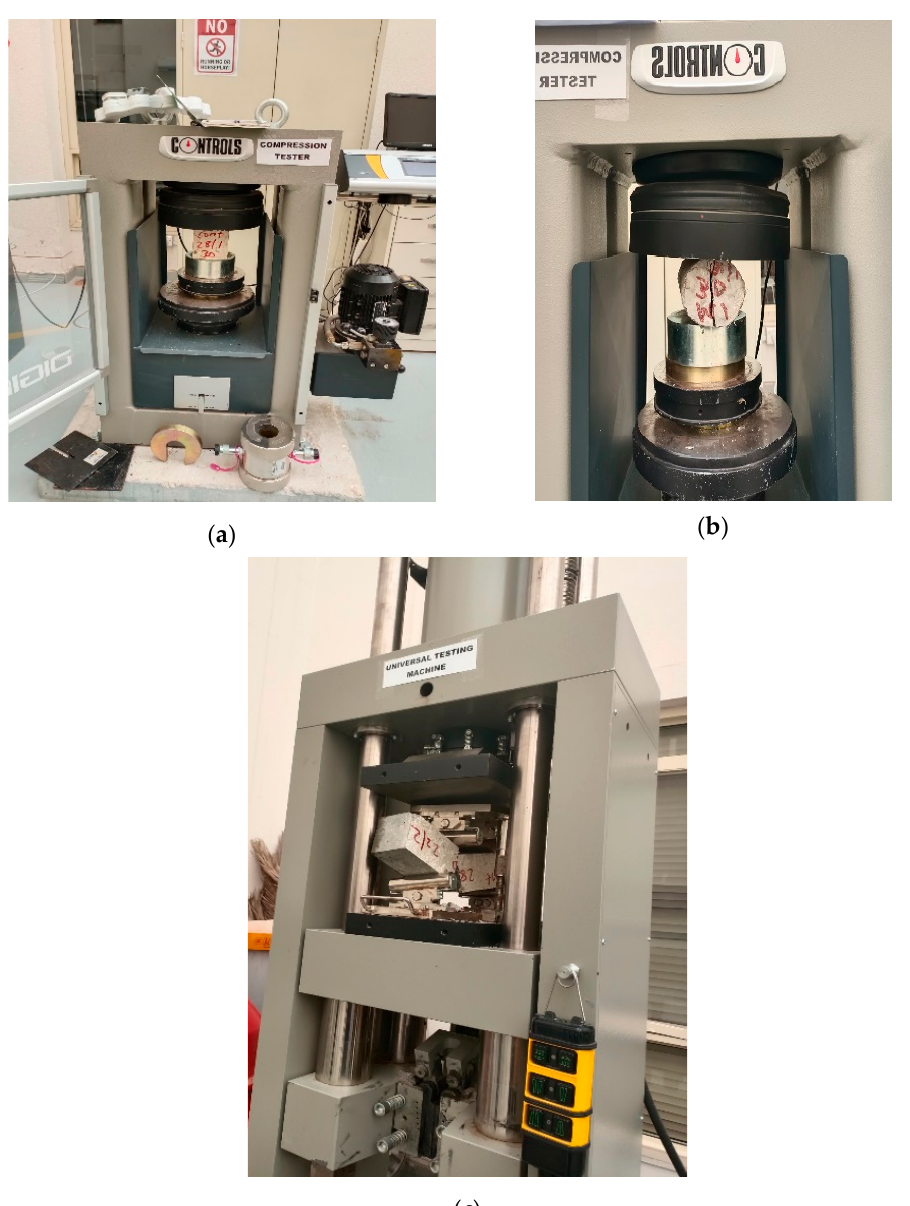
Figure 4 . Experimental Methods . ( a ) Compressive Strength Testing, ( b ) Split Tensile Strength Test- Figure 4. Experimental Methods. ( a ) Compressive Strength Testing, ( b ) Split Tensile Strength Testing, ing, ( c ) Flexural Strength Testing [4] . ( c ) Flexural Strength Testing